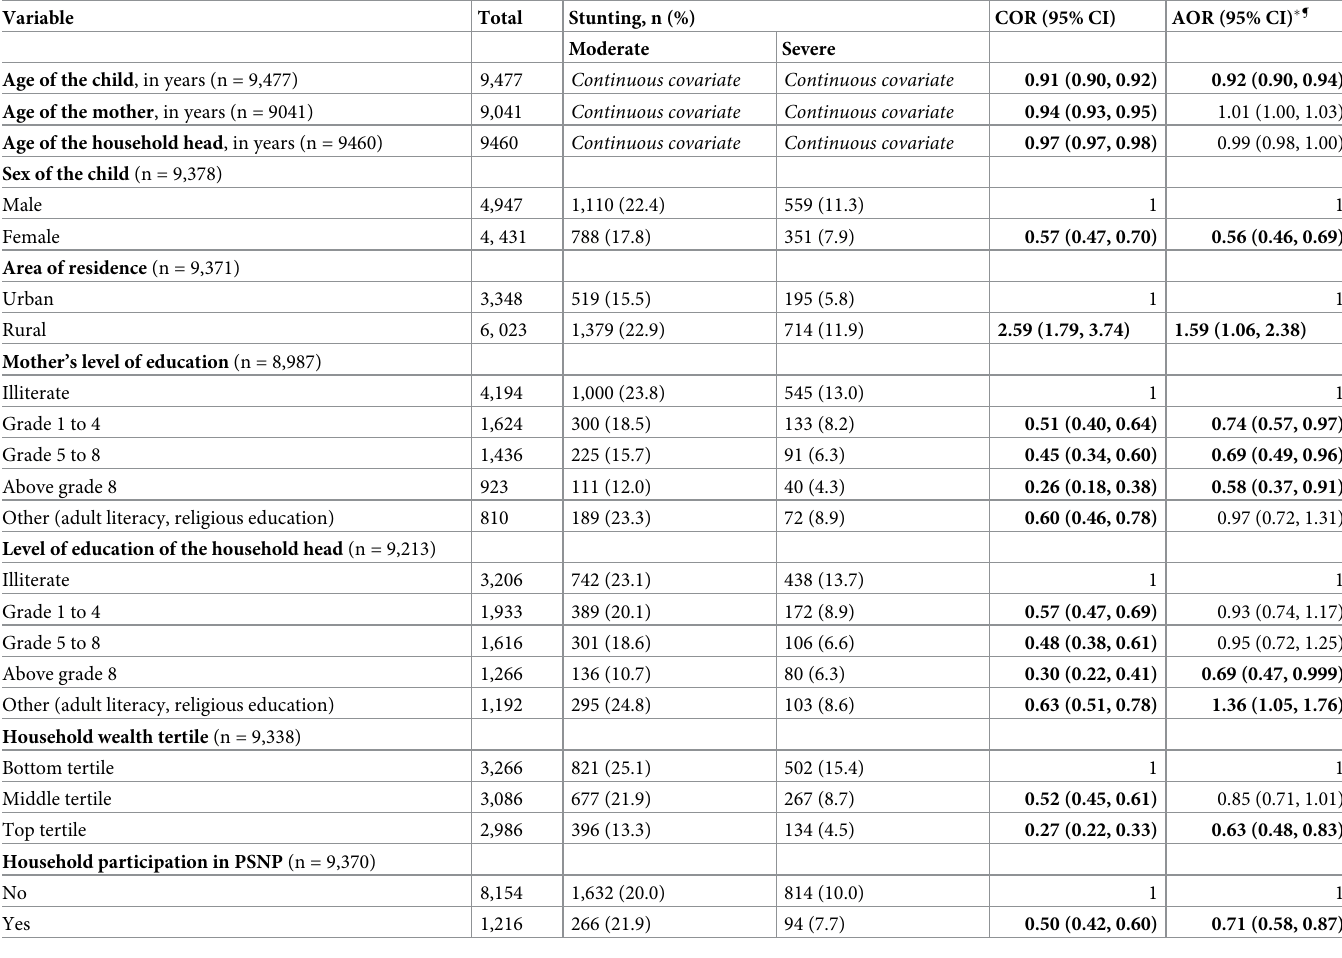
Table 4. Determinants of stunting in the younger cohort, Ethiopia,